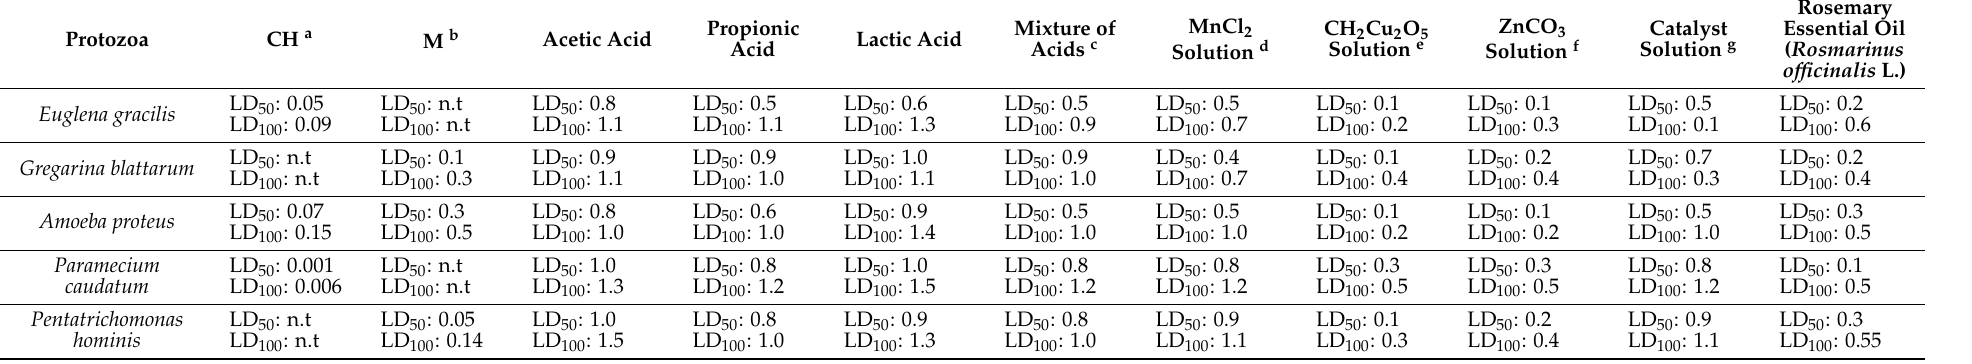
a —chloramphenicol, b —metronidazole, c —in rate 1:1:1, d —Manganese (II) chloride 10% solution, e —Copper (II) carbonate hydroxide 10% solution, f —Zinc carbonate 10% solution, g —5% solution, n.t—not tested. Table 9. LD 50 , LD 100 values [%] for the tested mixtures of rosemary essential oil ( Rosmarinus officinalis L.), organic acids (Acetic acid—A, Propionic acid—P, Lactic acid—L, Mixture of acids—M) and metal ion against selected protozoa. Rosemary Essential Oil ( Rosmarinus officinalis L.) Acetic Acid Propionic Acid Lactic Acid Protozoa Euglena